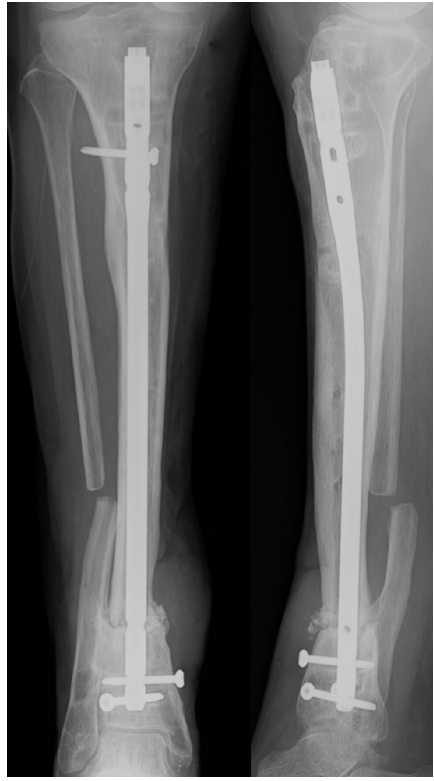
Figure 4. Follow-up X-ray after nail dynamization, in CFRI case report. Failed union at distal tibia with an osteolytic bone cyst in tibia, sclerotic lines around the distal